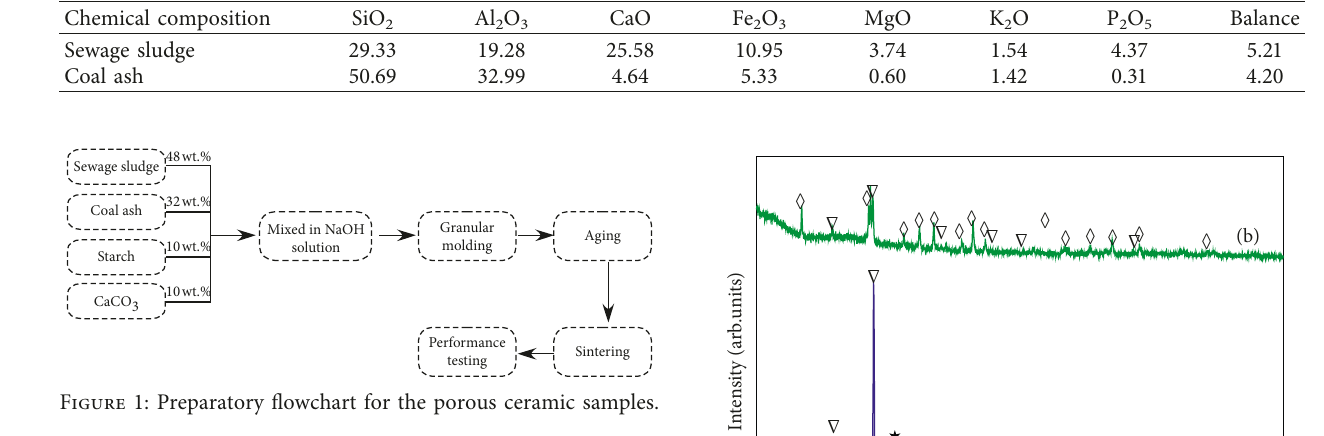
Table 1: The chemical composition of coal ash and sewage sludge.